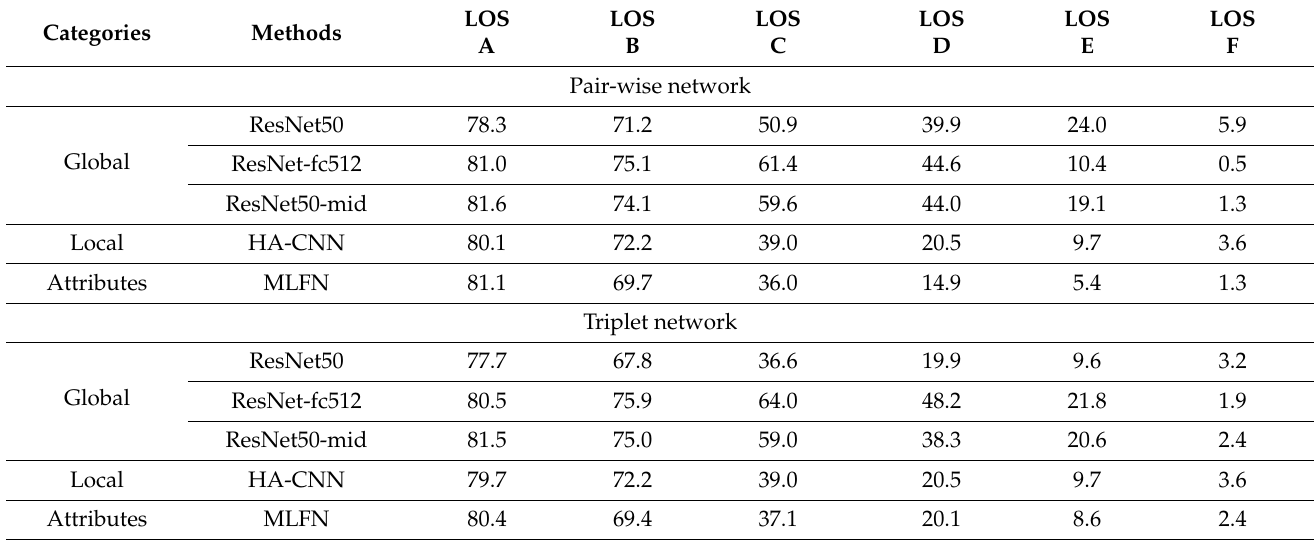
Table 2. The model performance using pair-wise and triplet networks.